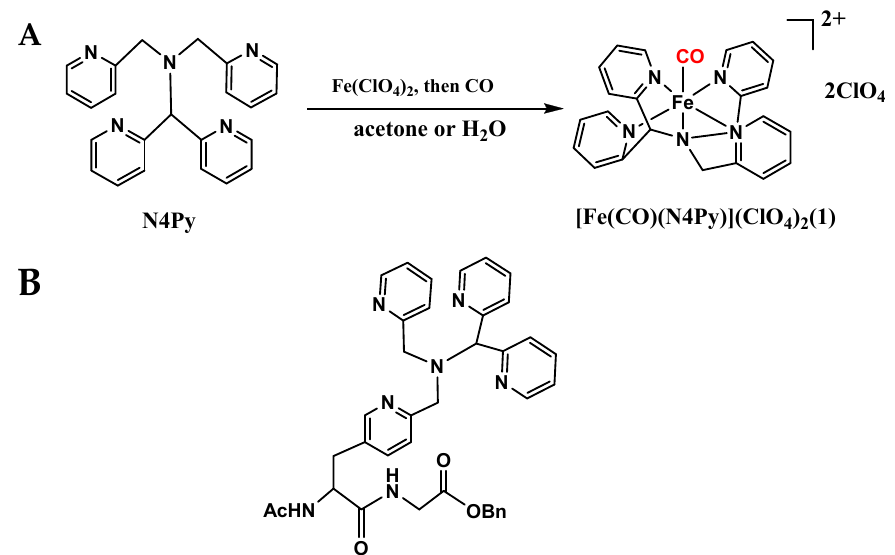
Figure 12. The ionic water-soluble Iron complexes [Fe II (CO)(N4Py)] ( A ) could be modified into Photo-CORMats by the replacement of the N4Py ligand with peptide china Ac-Ala-Gly-OBn ( B ) for the improvement of the cell-specific itself or tissue-specific therapeutic properties.